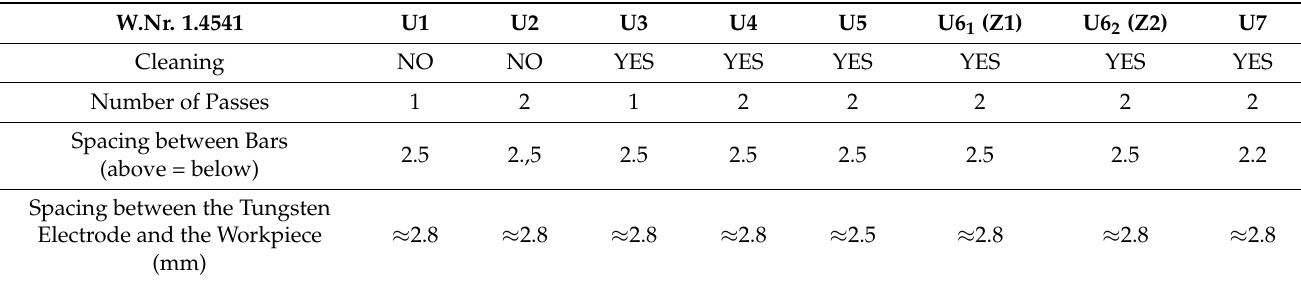
Table 4. Main experiment parameters.